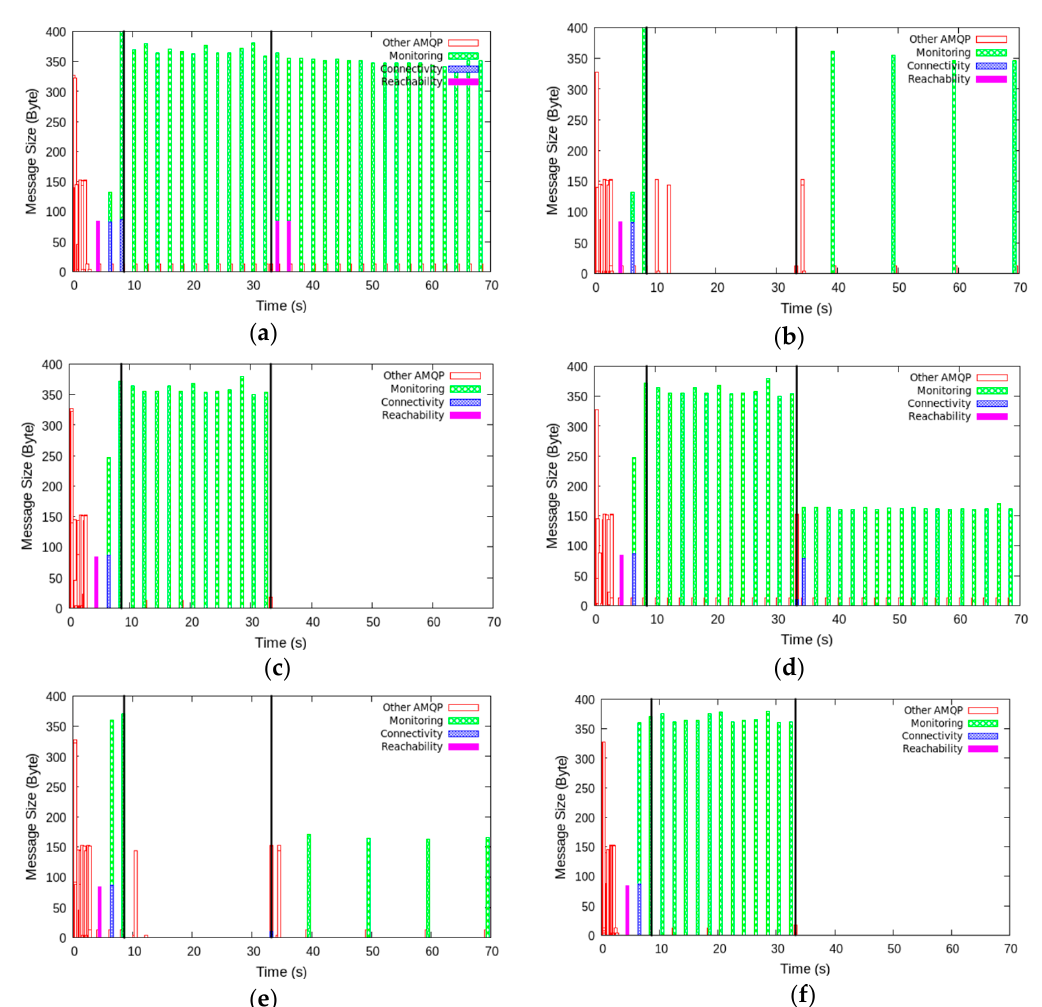
Figure 8. Monitoring information exchange adaptation. Di ff erent agent messages’ packets, the bootstrap and discovery stage at t = 9 s. The link was cut o ff at t = 33 s, C2 ↔ C3 link is cut o ff . ( a ) C1 → C2; ( b ) C1 → C3; ( c ) C2 → C3; ( d ) C2 → C1; ( e ) C3 → C1; ( f ) C3 → C2.